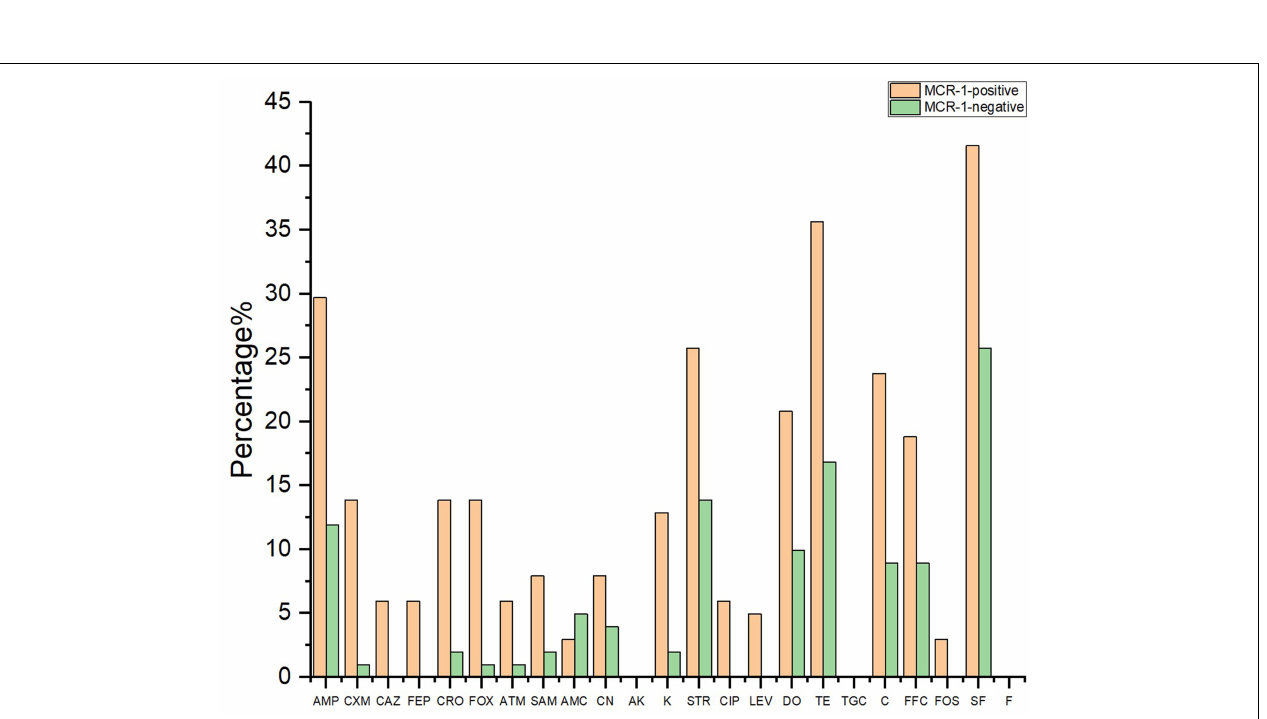
FIGURE 3 | The resistant rate of mcr-1 –positive and mcr-1 –negative E. coli to 23 antibiotics. AMP, ampicillin; CXM, cefuroxime; CAZ, ceftazidime; FEP, cefepime; CRO, ceftriaxone; FOX, cefoxitin; ATM, aztreonam; SAM, ampicillin–sulbactam; AMC, amoxicillin–clavulanic acid; CN, gentamicin; AK, amikacin; K, kanamycin; STR, streptomycin; CIP, ciprofloxacin; LEV, levofloxacin; TE, tetracycline; DO, doxycycline; TGC, tigecycline; C, chloramphenicol; FFC, florfenicol; FOS, fosfomycin; SF, sulfisoxazole; F, nitrofurantoin.